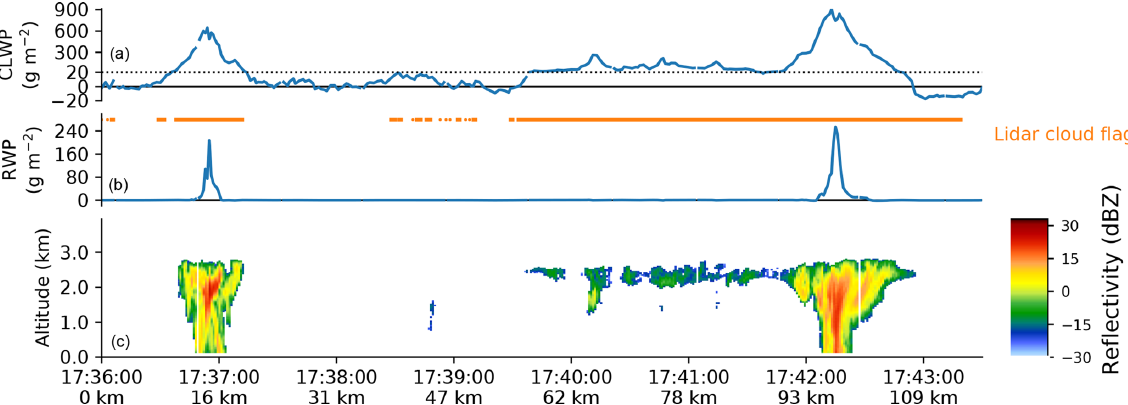
Figure 10. Example scene of rain retrieval from NARVAL1 research flight 8 on 20 December 2013. Retrieved CLWP (a) , retrieved RWP (b) , and radar reflectivity profile (c) . Note that the scale in (a) is piecewise linear, with a scale change at 20gm − 2 . The IWV varies around 31 . 5 ± 1 . 5kgm − 2 in this